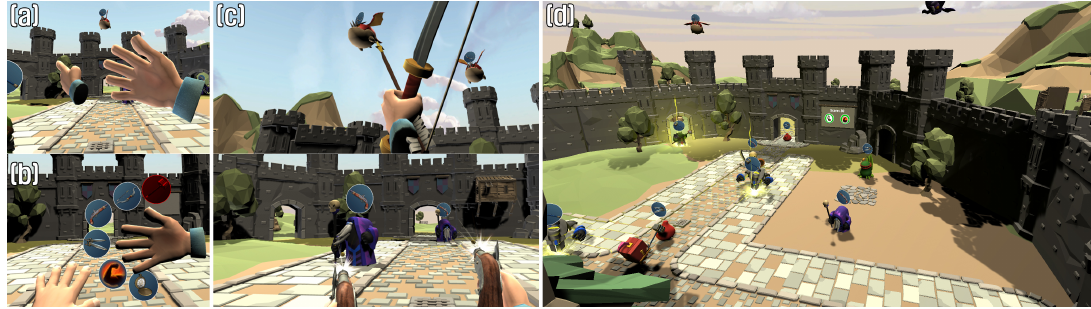
Figure 6. Application development result: ( a ) proposed interface; ( b ) existing GUI control method; ( c ) play scene; and ( d ) overall application